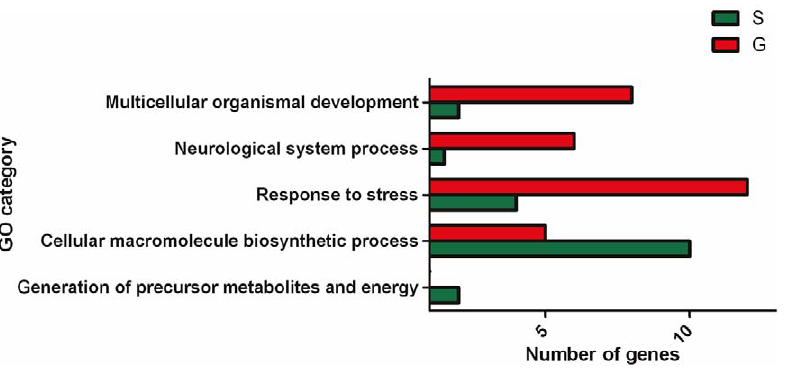
Figure 2. Classification of the annotated differentially expressed genes under GO categories. The number of transcripts classified under different GO terms that were more abundant in gregarious (red) and solitarious (green) locusts.